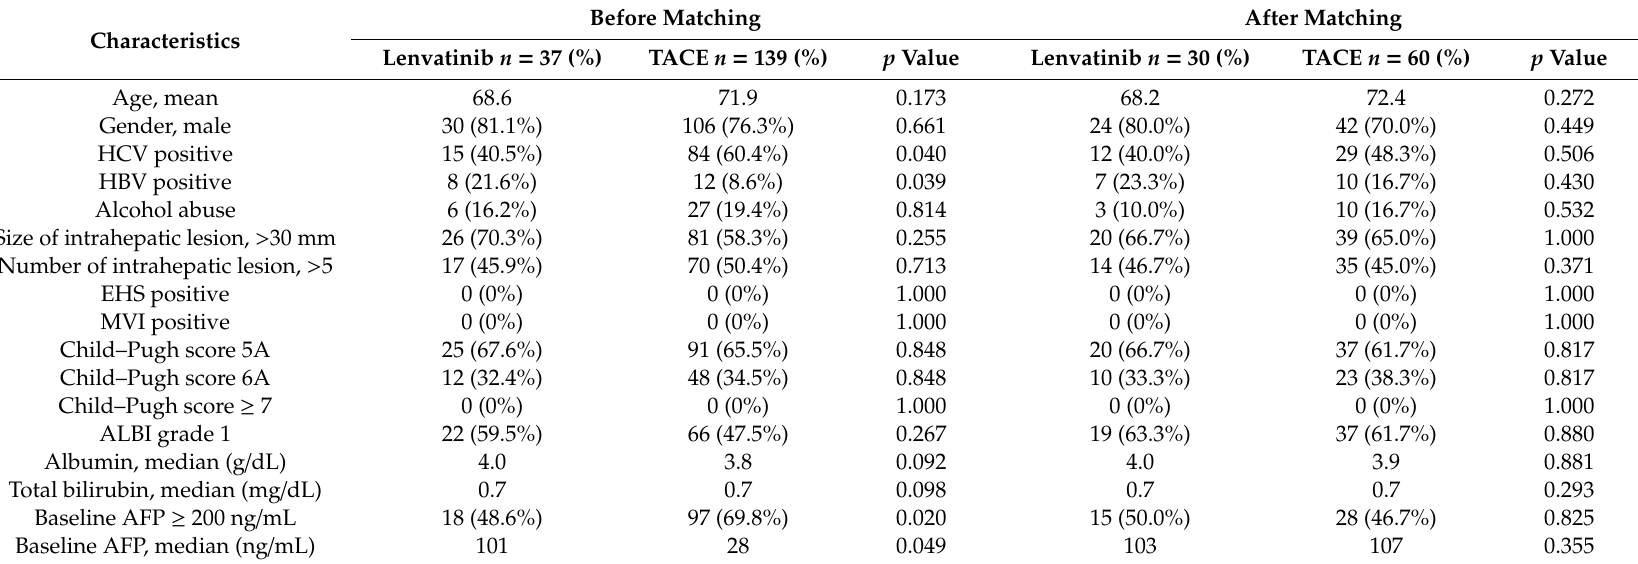
Table 1. Patient disease characteristics at the time of study entry before and after propensity score